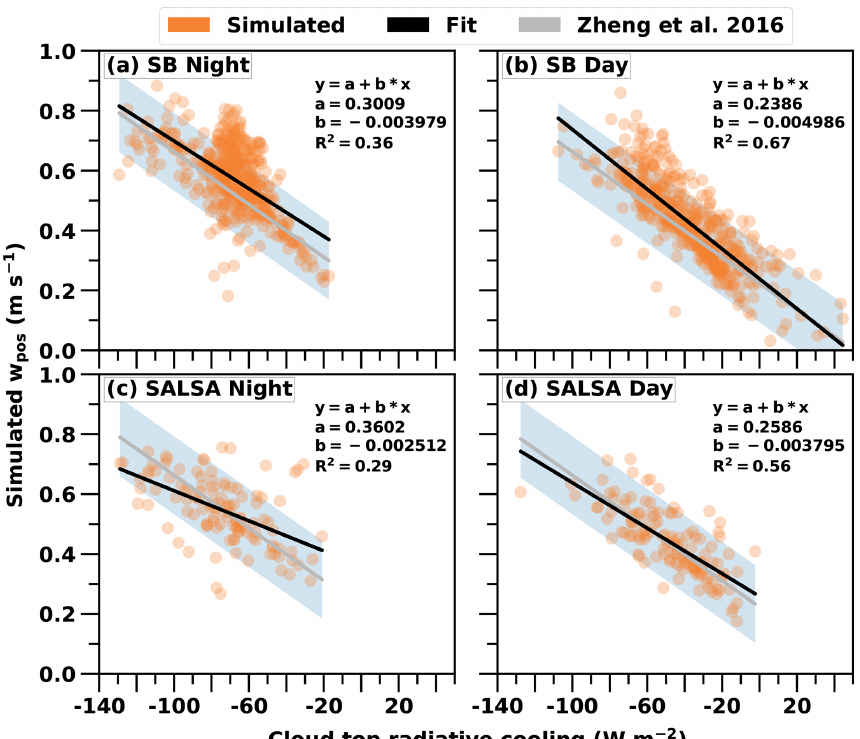
Figure 4. Simulated updraft velocities as a function of simulated cloud top radiative cooling values. Also shown are the linear fits to the data. R 2 is the coefficient of determination. SB and SALSA refer to Seifert–Beheng bulk microphysics and sectional microphysics, respectively. In daytime simulations, the solar zenith angle was used as one of the input parameters for the simulations. The grey lines and shading represent the Zheng et al. (2016) parameterisation with its uncertainty